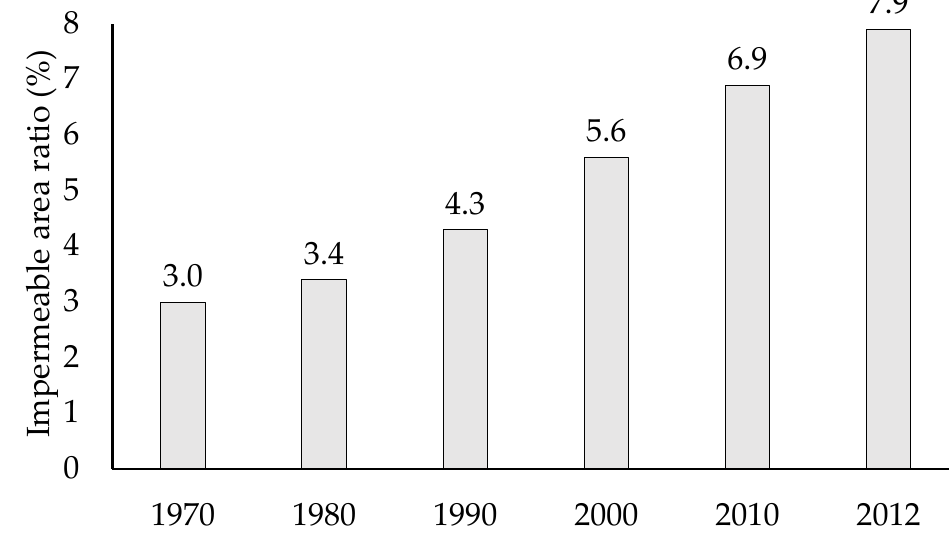
Figure 1. Increase of Impermeable Area in South Korea [7].